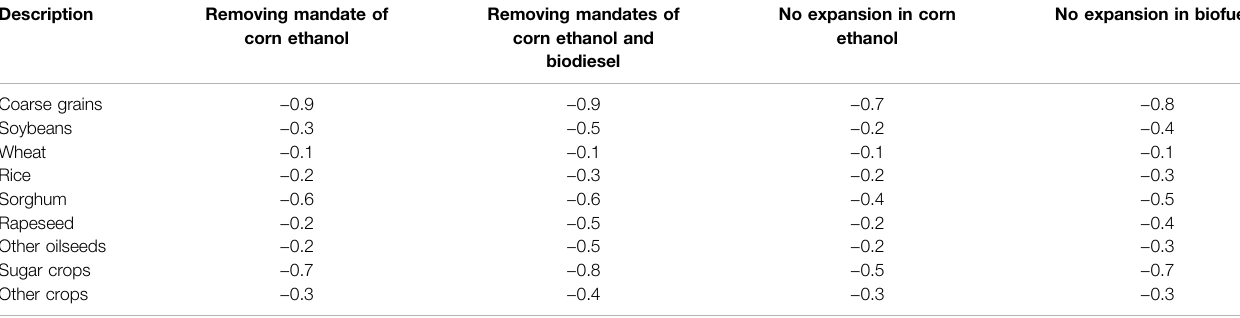
TABLE 5 | Percentage change in real commodity prices under alternative counterfactual experiments for 2011 – 2016. Description